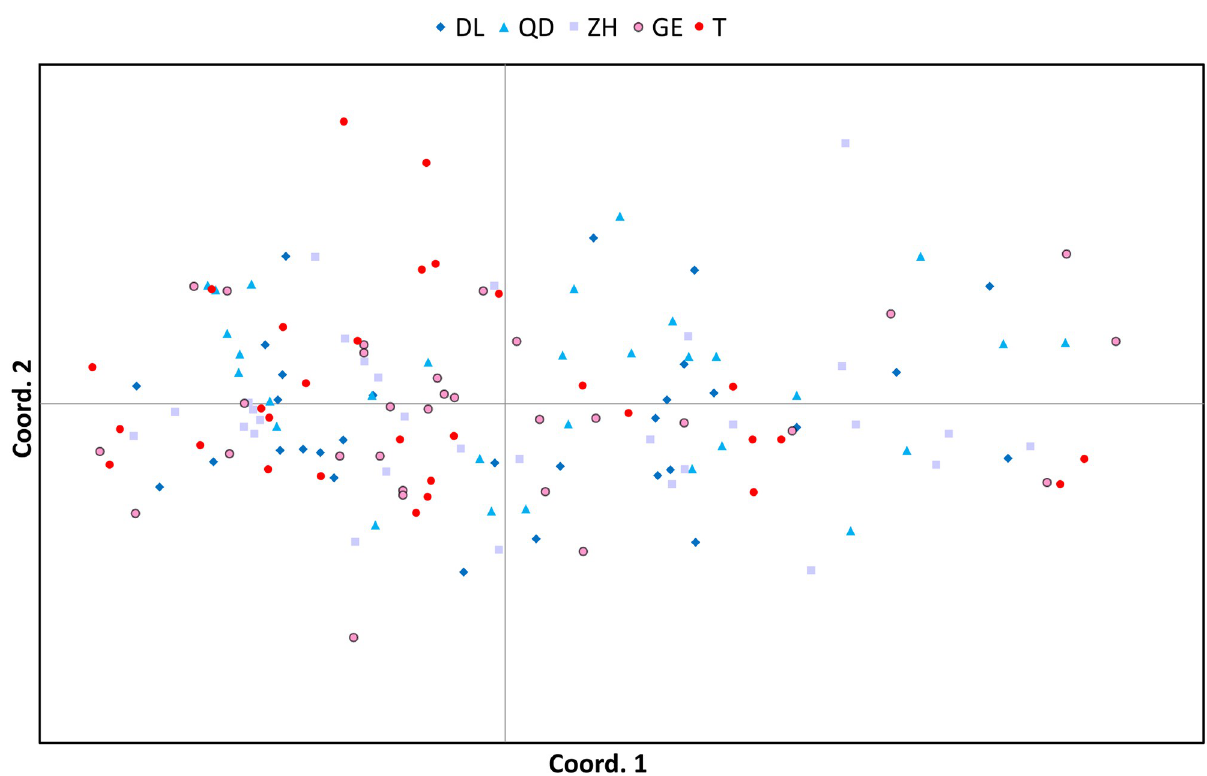
Fig 4. Plot of the first two axes of Principal Coordinate Analysis (PCoA) based on codominant genotypic distances of ten microsatellite loci for 150 T . japonicus individuals. Each dot represents an individual and is color-coded for the five locations reflecting latitudinal gradient (north: blue, south: red).